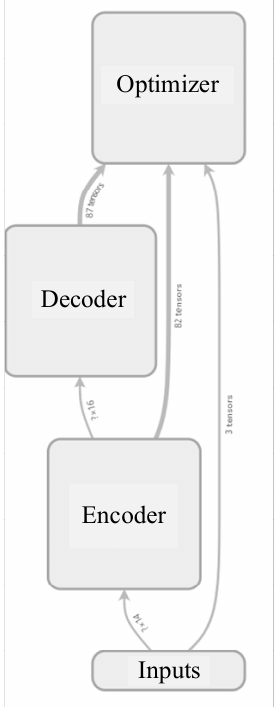
Figure 15. Structure of the encoder–decoder network within the framework of TensorFlow.